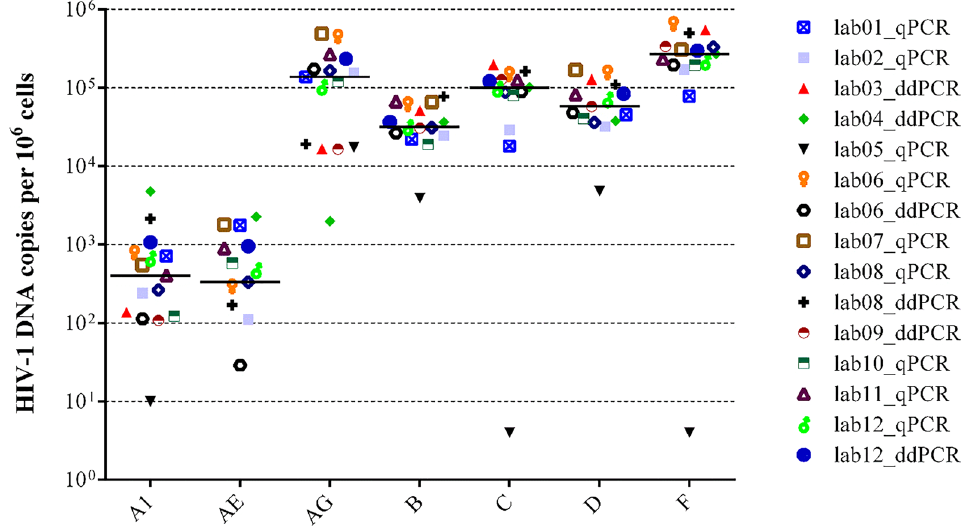
Figure 4. HIV-1 DNA (copies per 10 6 cells) measured by the participating laboratories in the DNA extracts from different HIV-1 subtypes. Bars indicate median values. Graphic elaboration was realized using the GraphPad Prism software version 6.0 (https:// www. graph pad. com/ scien tific- softw are/